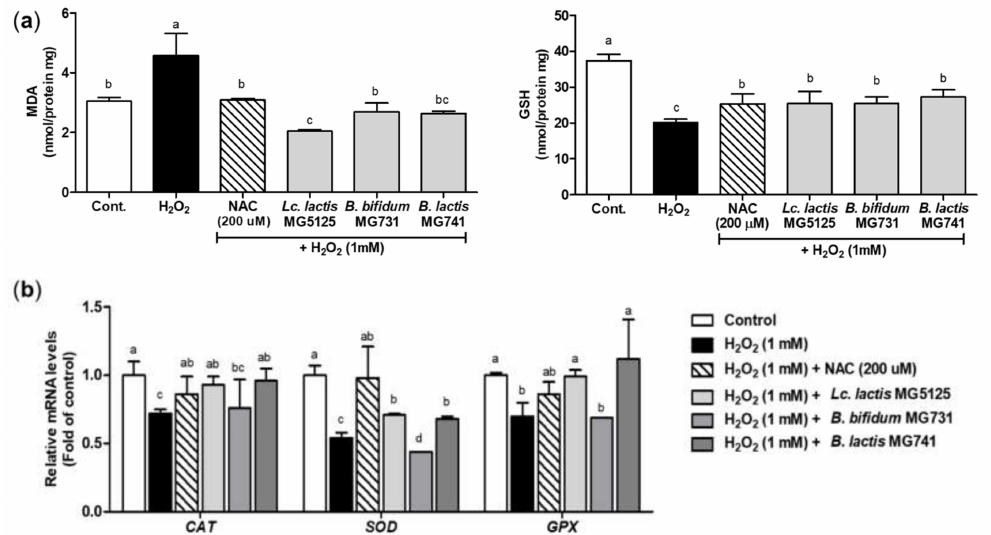
Figure 3. Antioxidant effect of the CFS of probiotics against oxidative stress induced by H 2 O 2 in hepatocytes. ( a ) MDA and GSH levels in H 2 O 2 -exposed hepatocytes pretreated with the CFS of probiotics. ( b ) mRNA levels of antioxidant enzymes (CAT, SOD, and GPx) in H 2 O 2 -exposed hepatocytes pretreated with the CFS of probiotics. The cells were pretreated with the CFS of probiotics for 24 h and then exposed to H 2 O 2 (1 mM) for 24 h. Each mRNA level was normalized to the GAPDH . The data represent the mean ± SEM ( n = 3). Different letters among columns indicate significance at p < 0.05, as determined by Duncan’s test. Cont., control; NAC, N